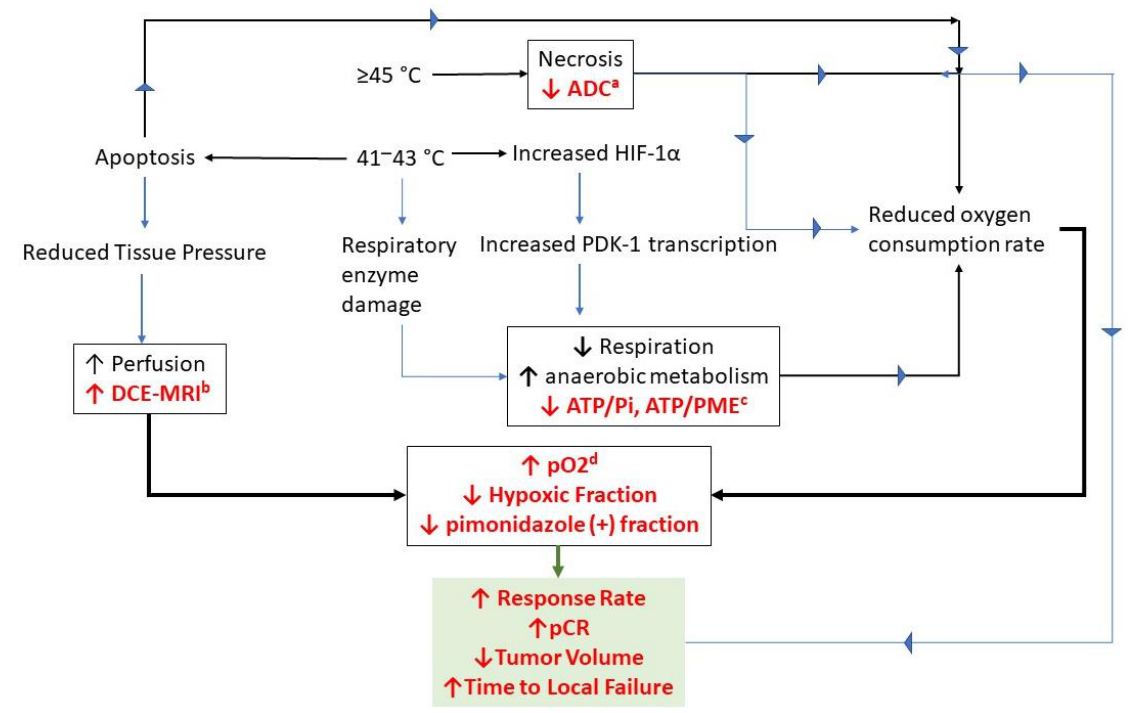
Figure 3. Potential mechanisms for reoxygenation following HT. The boxes in this figure contain putative mechanisms for reoxygenation, along with supportive data acquired from canine soft tissue sarcomas and/or human patients with soft tissue sarcomas or locally advanced breast cancer. The terms highlighted in red font are observations that support the proposed mechanisms. The box highlighted in green lists treatment responses that are linked back to the physiologic response observations. The superscripted letters next to the individual measurements refer back to the papers in which the observations were reported. a — [63]; b — [62,63]; c — [87]; d — [62,63,104,107,118]. The temperatures listed are linked to typical heating times of 60 min per HT fraction.